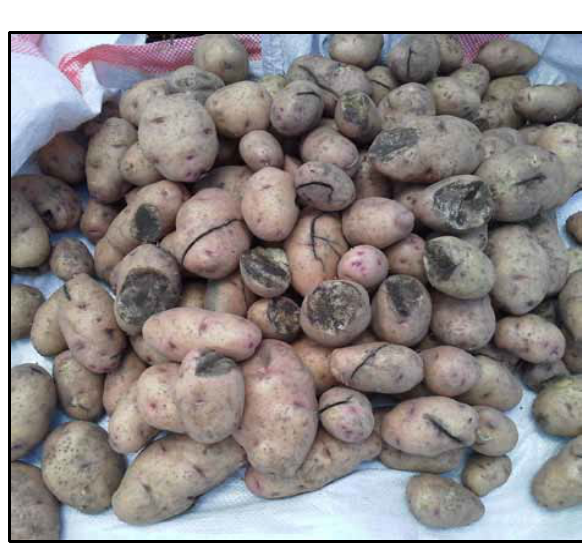
Figure A3. Opening a potato bag after transport. Figure A1. Opening a potato bag after